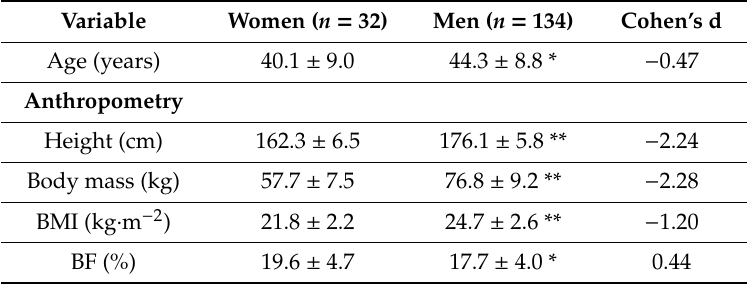
Table 1. Anthropometric characteristics and body composition by